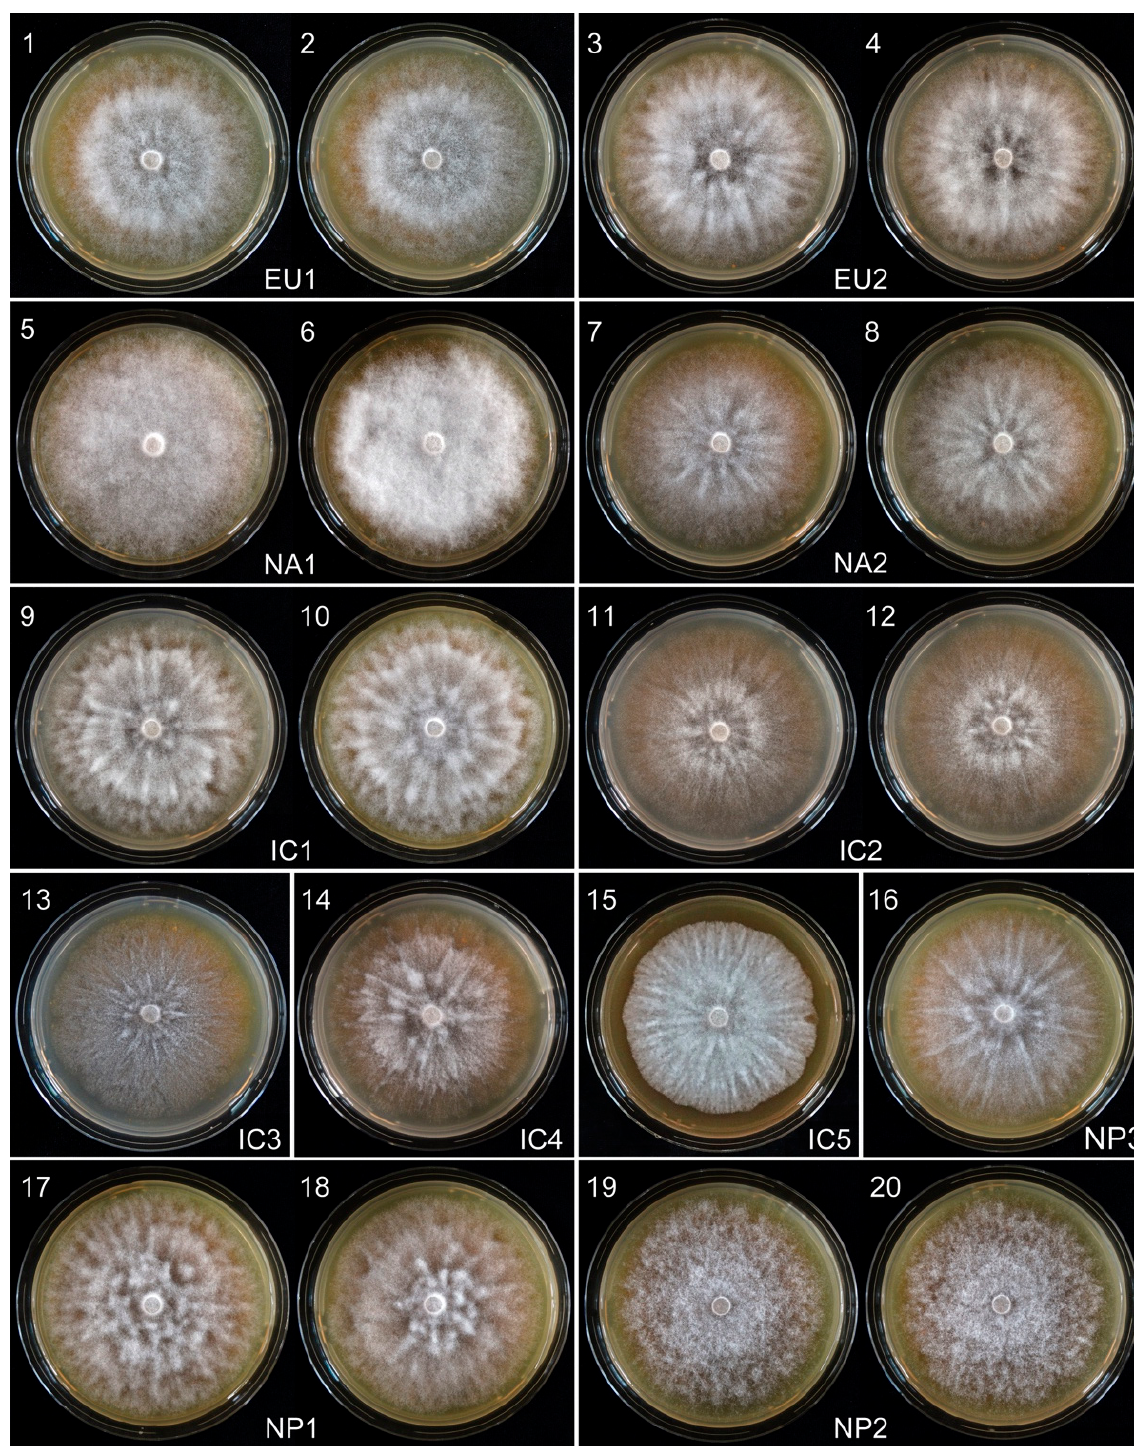
Figure 3. Colony morphologies of four known lineages (EU1, EU2, NA1 and NA2), five new Indochina lineages (IC1-IC5) and three new Japanese lineages (NP1-NP3) of Phytophthora ramorum after 7 days growth at 20 °C on CA. Isolate codes as follows: 1, P1376; 2, P1578; 3, P2460; 4, P2461; 5, P1403; 6, P1496; 7, P2056; 8, P2058; 9, VN160; 10, VN856; 11, VN150; 12, VN169; 13, VN88; 14, VN851; 15, VN863; 16, JP975; 17, JP236; 18, JP718; 19, JP387 and 20, JP462.